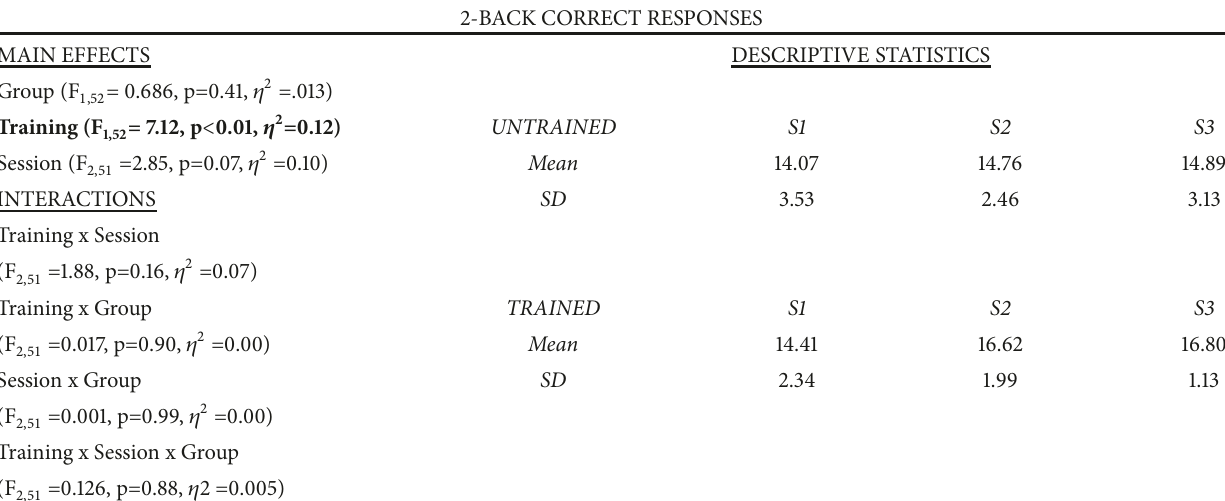
(a) 2-backcorrectresponses.OmnibusesoftheANCOVA(covariates:sexandage)forthenumberofcorrectresponsesduring2-backperformance.Descriptive statistics are provided as mean and standard deviation. Statistically significant effects are highlighted in bold. 2-BACK CORRECT